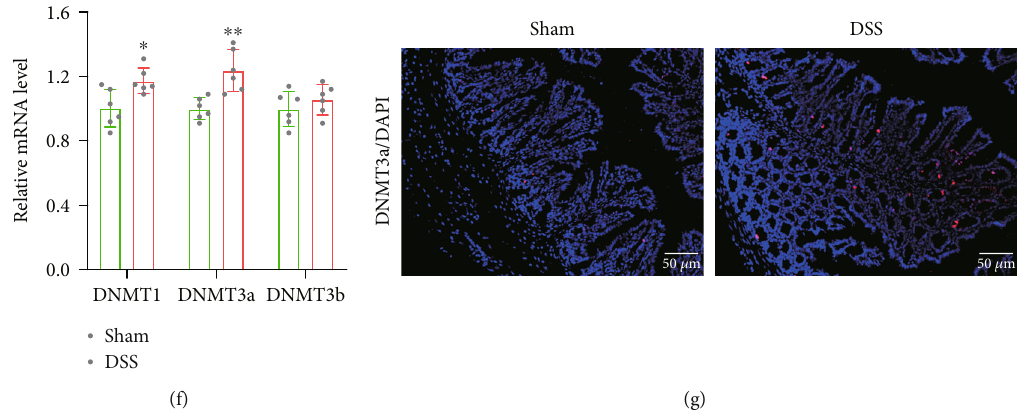
Figure 2: DSS treatment induces intestinal epithelial barrier dysfunction and DNMT3a level. The intestinal epithelial tissues of mice in the sham and DSS group were collected. (a) and (b) ZO-1 and occludin levels in intestinal epithelial tissues were measured by immuno fl uorescence staining and western blotting. (c) Levels of in fl ammatory cytokines containing L-10, TGF- β , IL-6 and TNF- α in serum of mice were evaluated by ELISA. (d) The number of CD1d+ B cells and CD138+ B cells in intestinal epithelial tissues was detected by fl ow cytometry. (e) Total DNA methylation level was measured. (f) The expressions of DNMT1, DNMT3a, and DNMT3b were detected. (g) DNMT3a protein level was determined by immuno fl uorescence staining assay. ∗ p < 0 : 05 , ∗∗ p < 0 : 01 , ∗∗∗ p < 0 : 001 vs. sham group; scale bar = 50 μ m